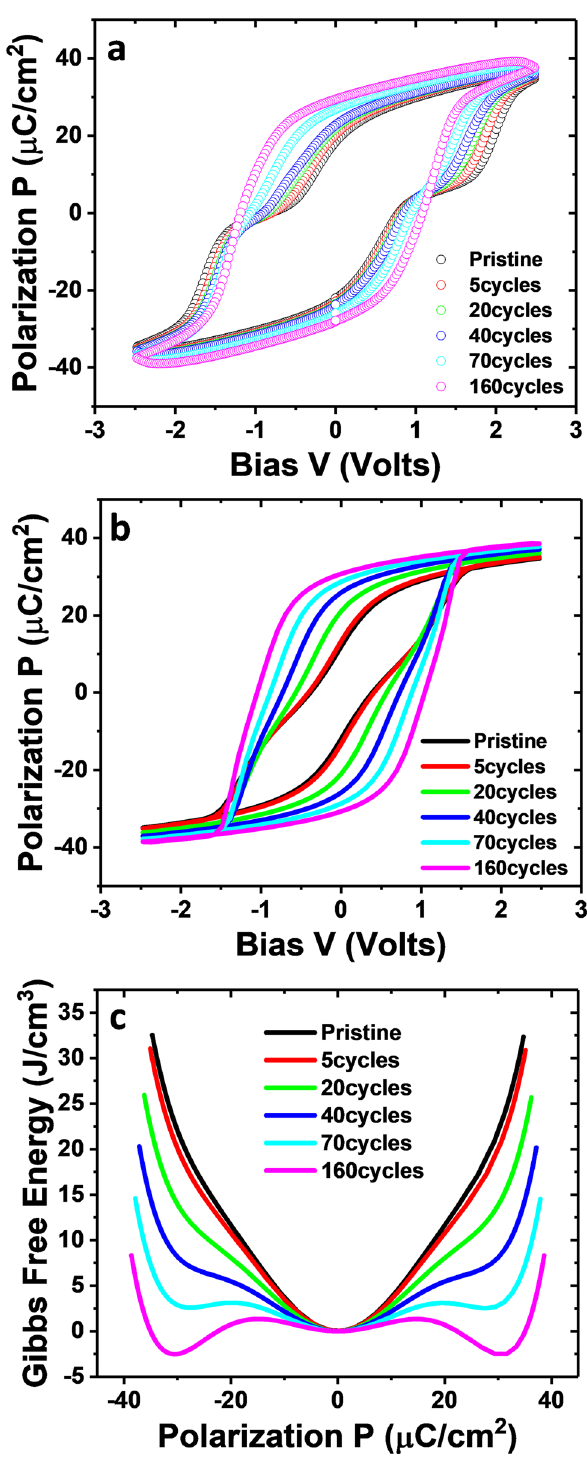
Fig. 8 Stabilization of ferroelectricity by fi eld cycling. a Experimental polarization P – voltage V curves, ( b ) polarization P – voltage V simulation and ( c ) Gibbs free energy landscape for different number of cycles. The simulation is performed with D it = 1.4 × 10 13 eV − 1 cm − 2